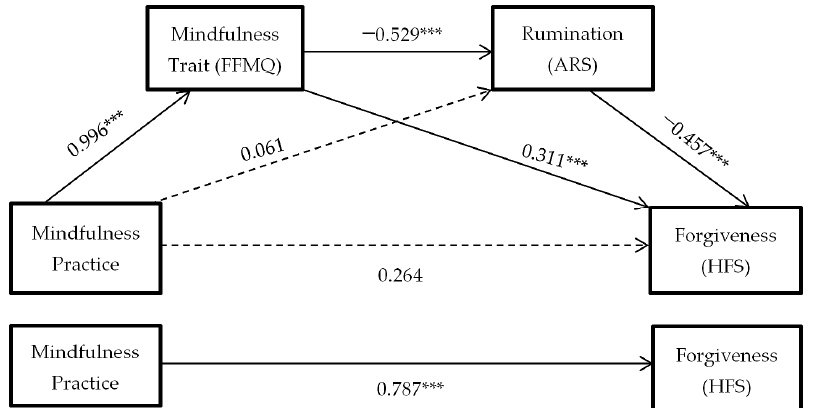
Figure 2. Hypothesized mediation model: spillover effect of mindfulness practice on forgiveness through mindfulness trait and rumination. Total effect of independent variable on dependent variable. *** = p < 0.001.